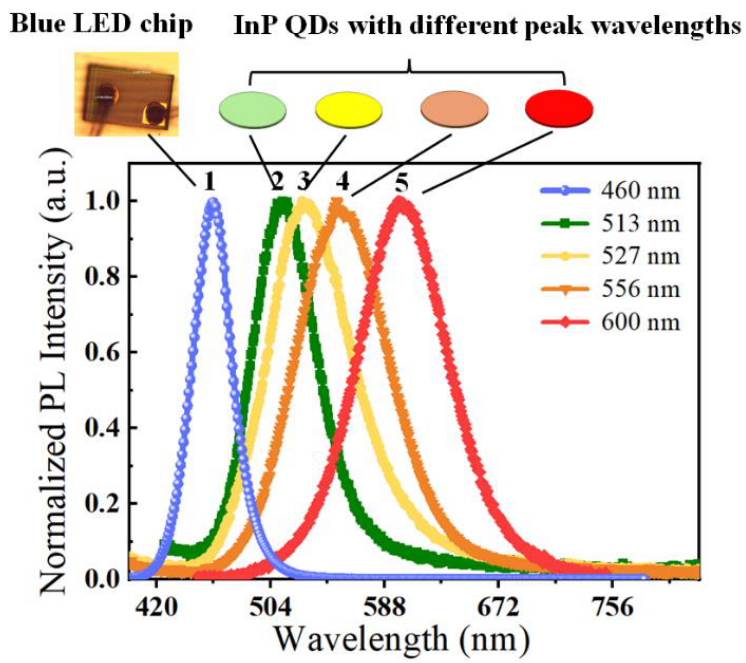
Figure 1. Monochromatic spectra produced by the blue LED chip and InP QDs with different peak wavelengths. The peak wavelengths of humps 1 to 5 are 460, 513, 527, 556, and 600 nm, respectively. Since it is unavoidable to cause shifts in CCT and Ra values when we adjust the light intensity of commercial WLEDs, we strategically adopt a WLED structure that consists of three blue LED chips and two species of InP QD materials. As shown in Figure 2, two blue LED chips are respectively packaged with InP QD films with different peak wavelengths. The other naked blue LED chip is placed to provide supplementary blue light for the trichromatic WLED. Thus, the optical spectra of this WLED system possesses three humps, and can be dynamically adjusted by controlling the driving currents of three independent blue LED chips ( I i , I j , and I k ) to obtain different CCT values. Here, we give the calculation method of I i , I j , and I k as